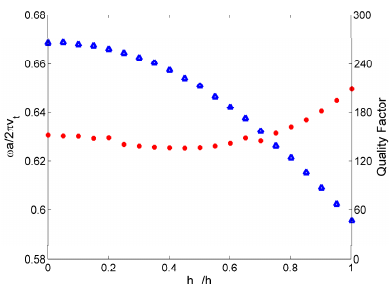
Figure 11. The evolutions of the WGM 1 frequency ( blue triangle dots ) and its corresponding quality factor ( red circle dots ) as a function of the filled mercury height. The geometric parameters are h/a = 0.45, r/a = 0.4, l/a = 0.2, r i /a = 0.11.